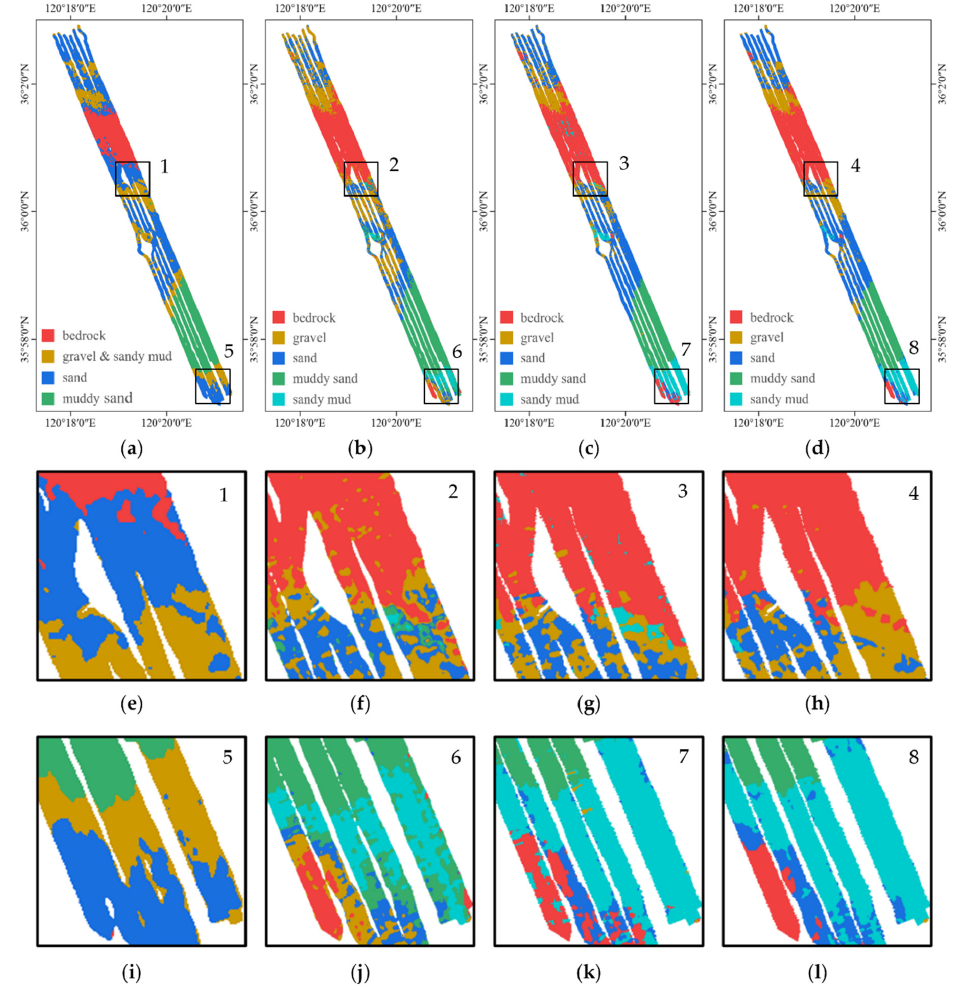
Figure 13. The comparison of sediment maps of different classifiers. ( a – d ) are the sediment maps of DFC, BPNN, SVM, our method, respectively; ( e – h ) are the details of areas 1–4 respectively; ( i – l ) are the details of areas 5–8 respectively. Table 5. Classification accuracy of different classifiers.